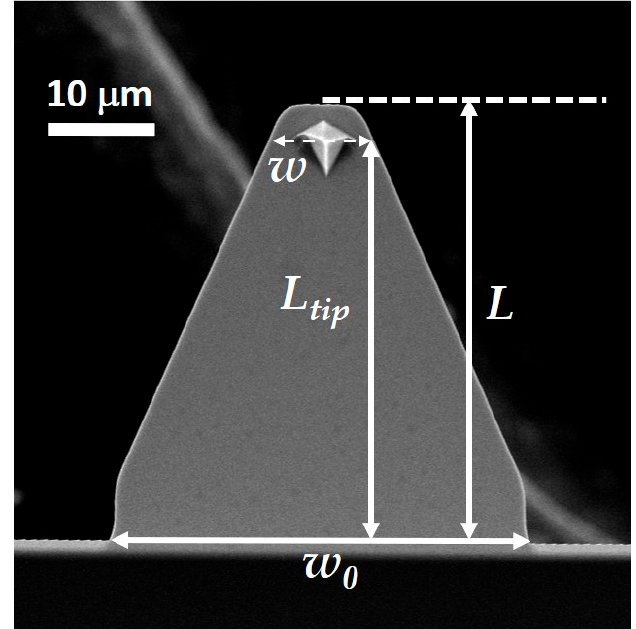
Figure 3. Plan-view SEM image of trapezoidal-shaped Bruker FastScan C cantilever.